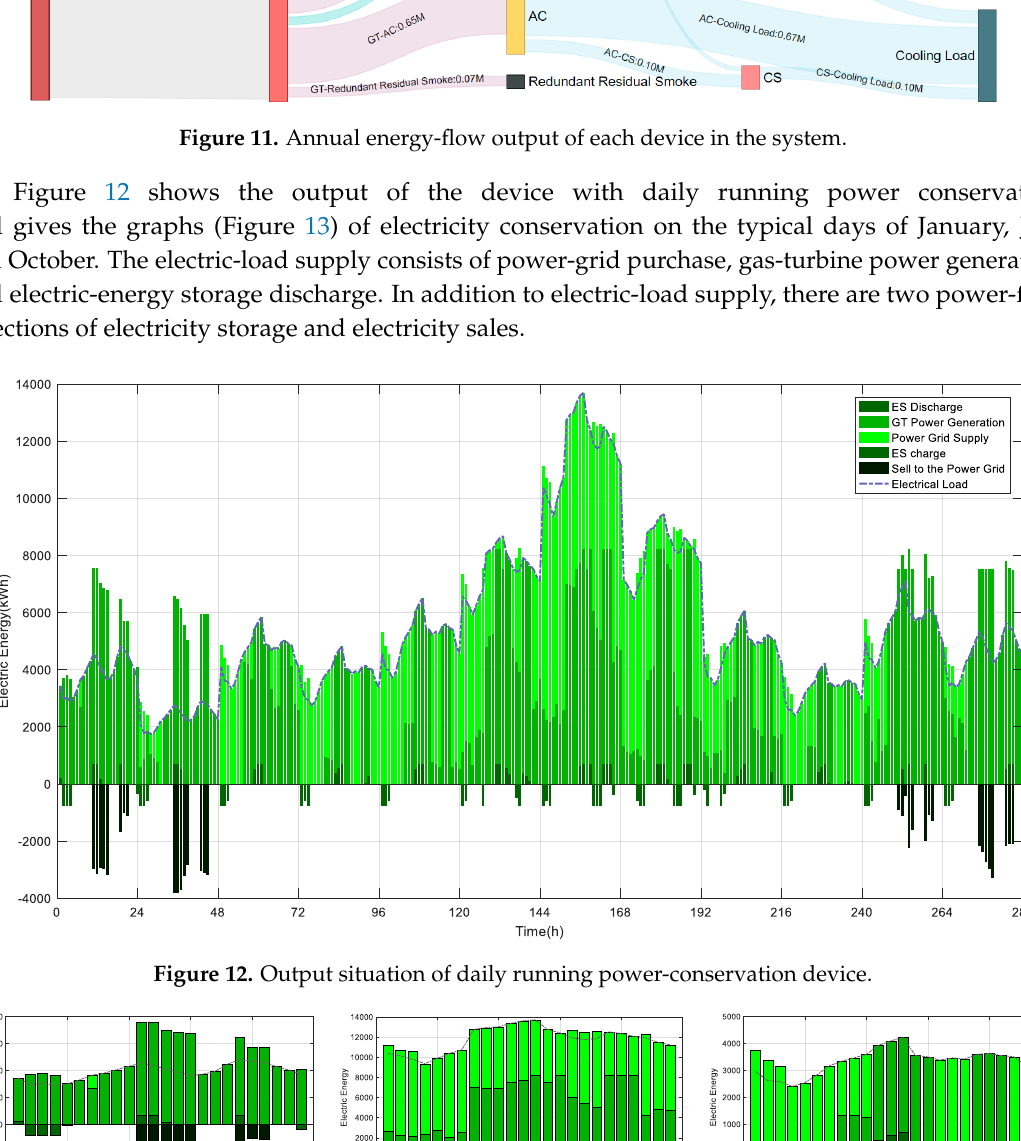
Figure 11. Annual energy-flow output of each device in the system.